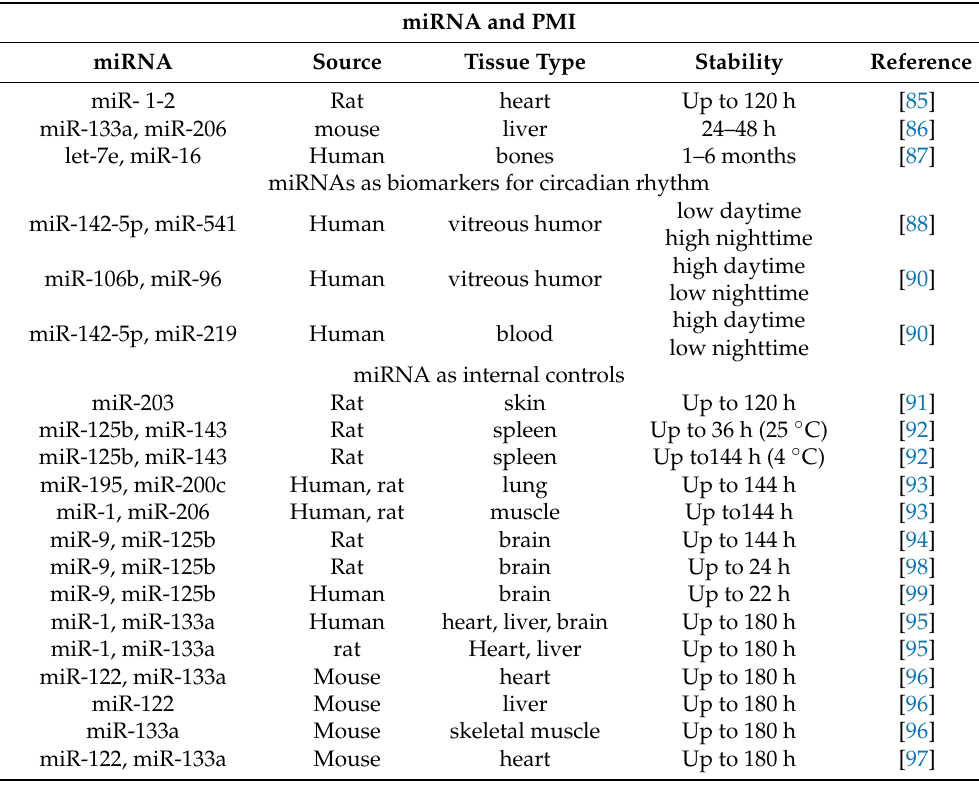
Table 2. Candidate miRNAs identified in the literature for